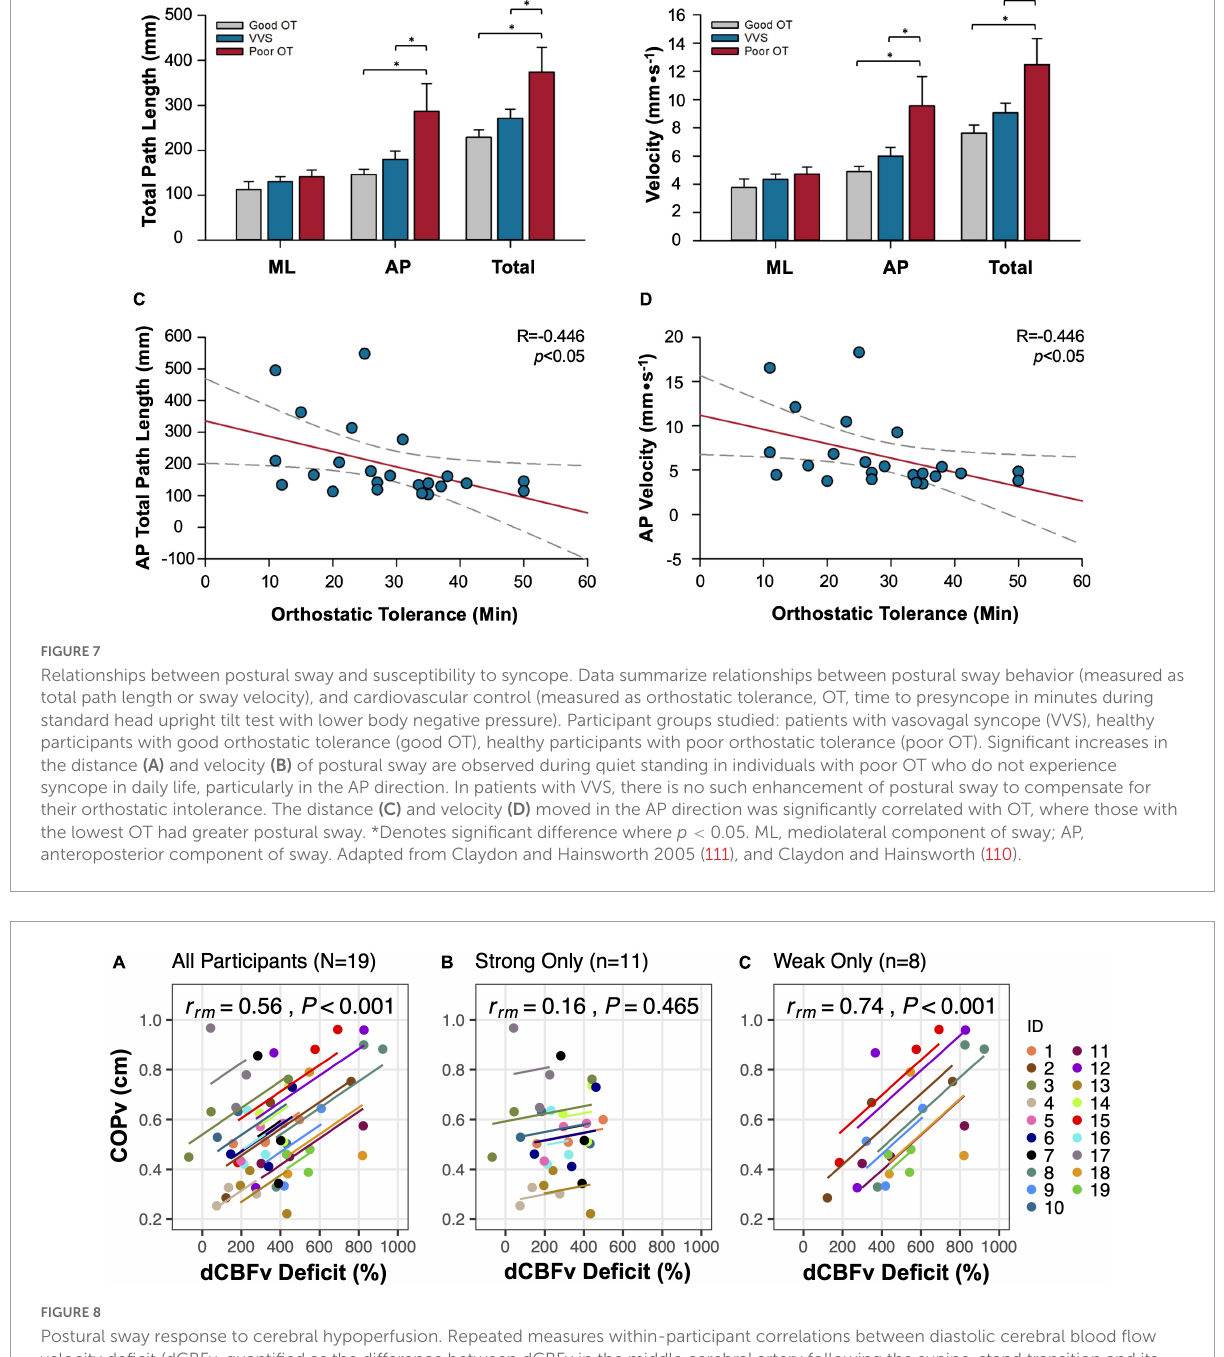
pressure (130) and cerebral hypoperfusion (117, 131) increase postural sway in quiet standing. Similarly, during a quiet stand following a supine-stand transition, the total path length of sway